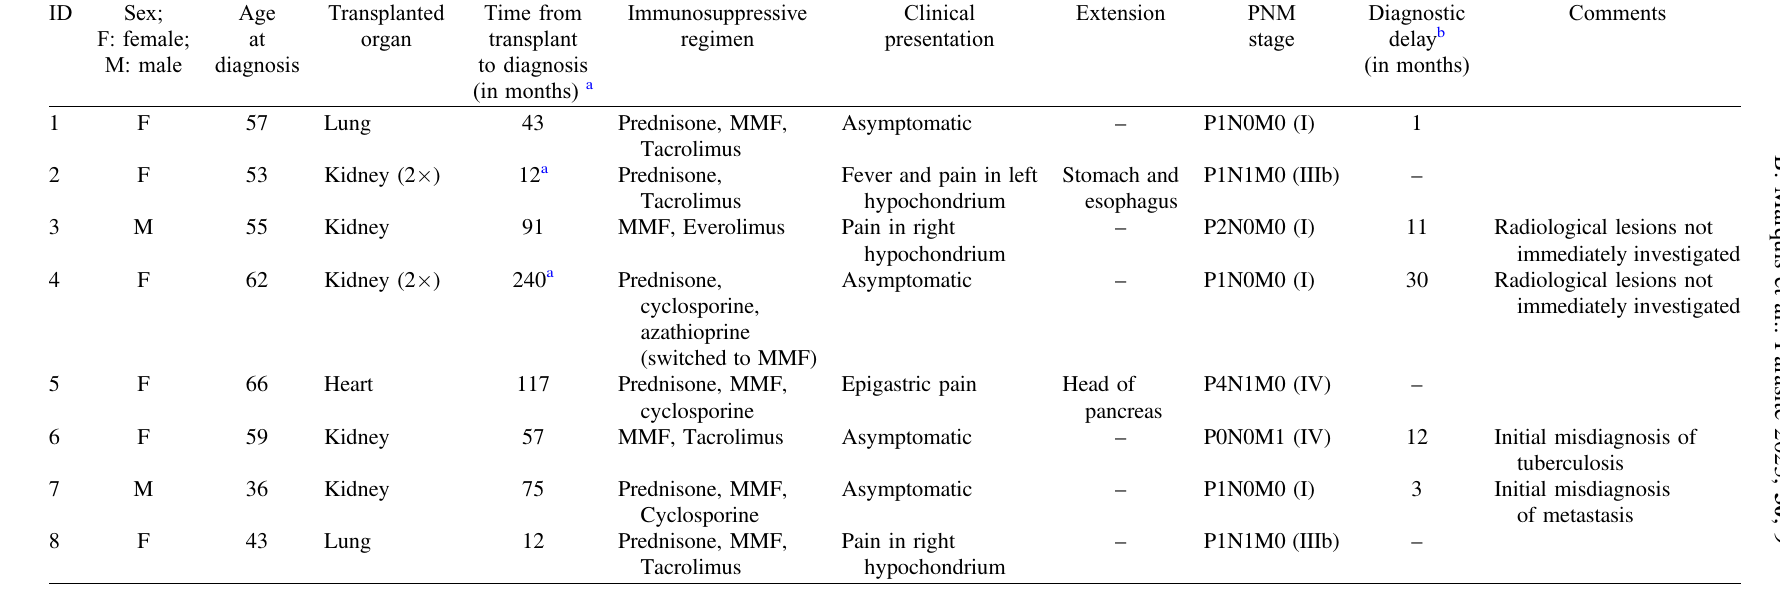
a Time from the fi rst transplantation to diagnosis.